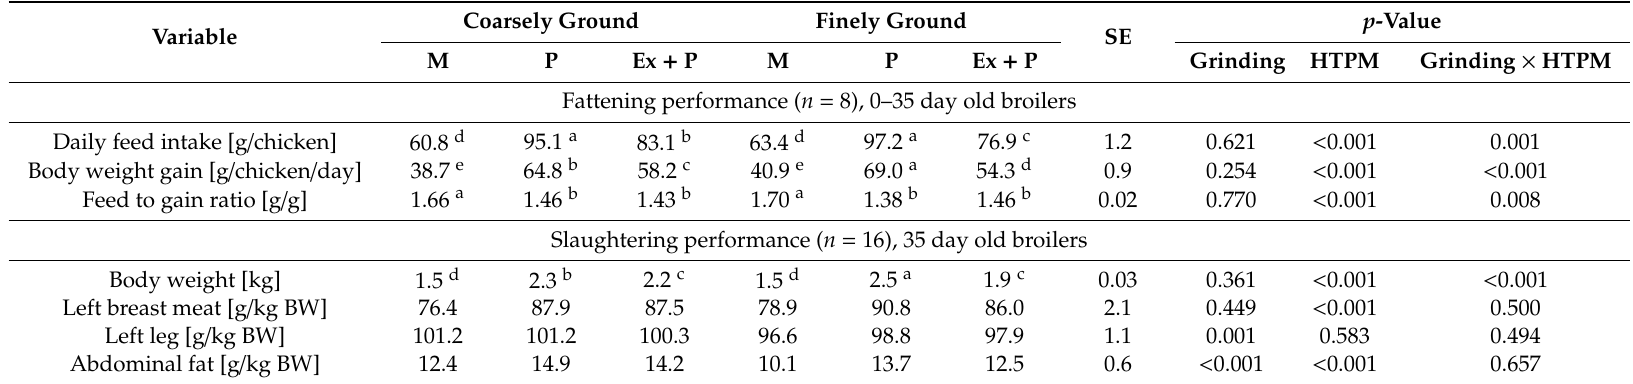
Table 6. Fattening and slaughtering performance and water consumption